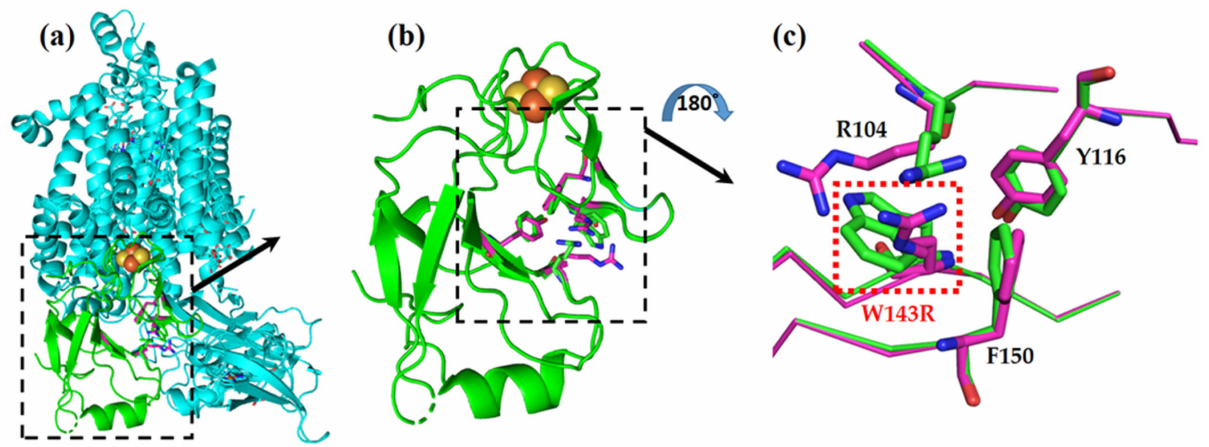
Figure 4. W143R mutation in Rieske protein of the cytochrome b6f complex, represented by two overlaid models: native (cyan and green) and the TSP9 mutant (magenta). ( a ) The cytochrome b6f complex from the membrane plane view, with the Rieske protein colored in green, and the rest of the subunits shown in cyan. ( b ) Close-up of the Rieske protein alone, from the membrane plane view. The 2Fe-2S cluster in orange and yellow can be seen in the proximity of the affected amino acids. ( c ) Close-up view of the W143R mutation site (red box) and the affected neighboring residues, arginine (R104), tyrosine (Y116), and phenylalanine (F150). The model view was rotated by 180 degrees to better show the mutation